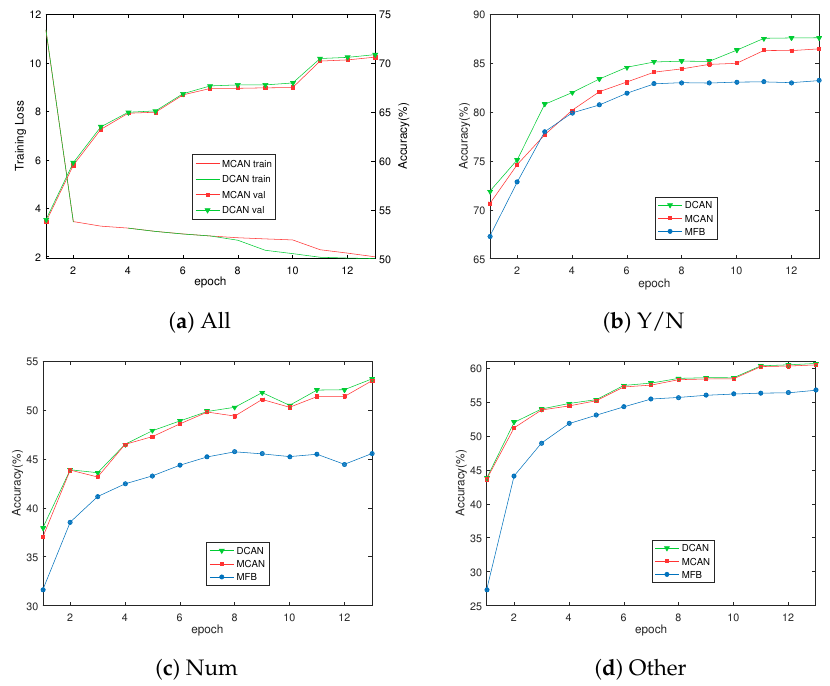
Figure 5. ( a ) The training loss and validation accuracy vs. epoch of MCAN and DCAN. BCE loss is used for all methods; ( b – d ) the overall and per-type accuracies of DCAN, MCAN, and